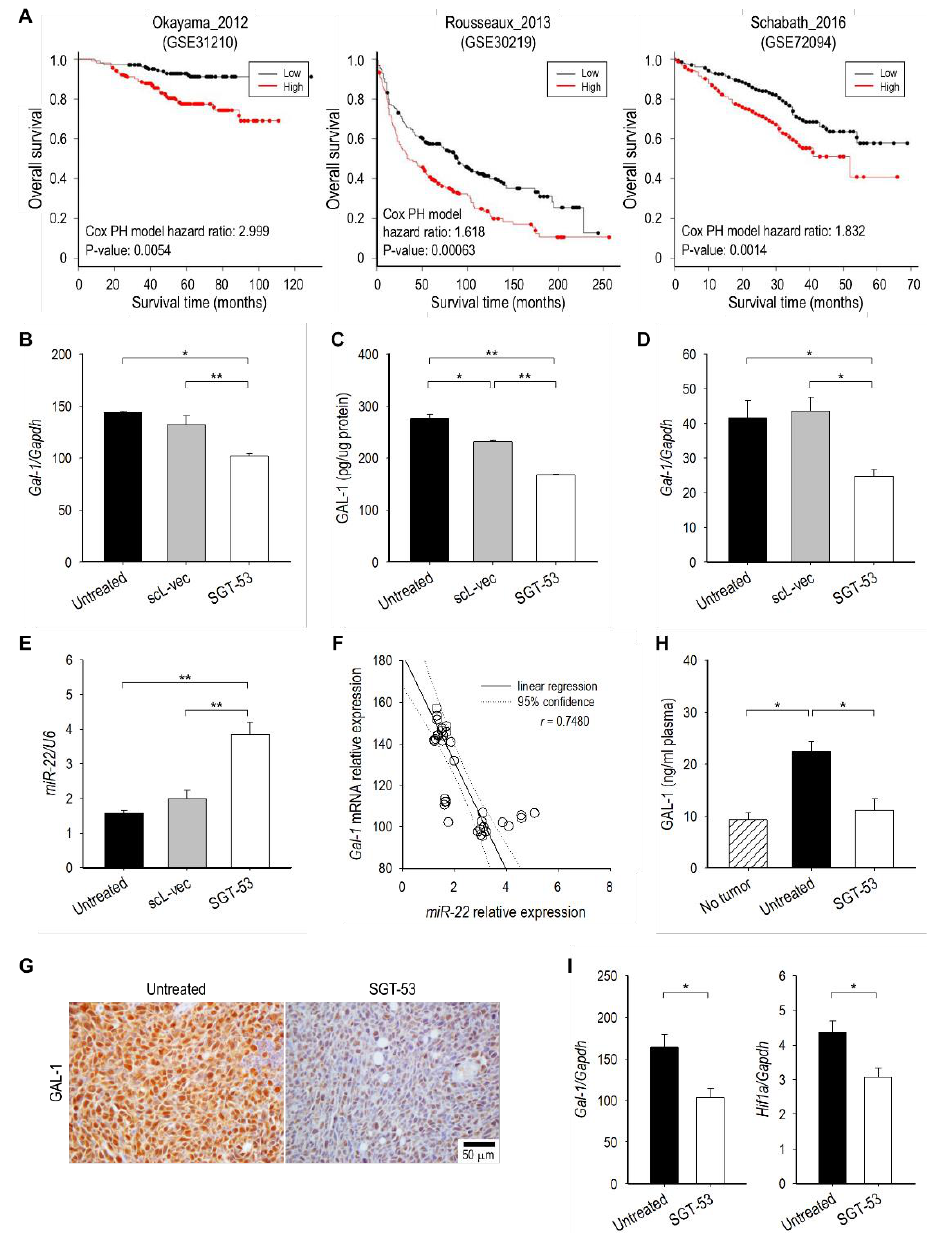
Figure 6. SGT-53 treatment represses immunosuppressive Gal-1. ( A ) Survival analysis of Gal-1 expression in lung cancer patients. Gal-1 expression in LL/2 cells transfected with either SGT-53 or scL-vec was assessed at ( B ) the mRNA level by RT-qPCR and ( C ) the protein level by ELISA immunoassay. ( D ) Expression of Gal-1 was assessed in human NSCLC cell H358 by RT-qPCR. ( E ) Quantitative analysis of miR-22 in LL/2 cells using RT-qPCR. ( F ) The correlation between miR-22 and Gal-1 mRNA levels in LL/2 cells. The circles indicate individual sample. ( G ) IHC examination of Gal-1 expression in LL/2 tumors. Representative images of Gal-1 staining are shown. ( H ) Quantitative analysis of Gal-1 protein in plasma using ELISA immunoassay. ( I ) Expression of Gal-1 and Hif1a was assessed in LL/2 tumors by RT-qPCR. Data are presented as mean ± SEM and were analyzed by Student’s t test. * p < 0.05, ** p < 0.001.